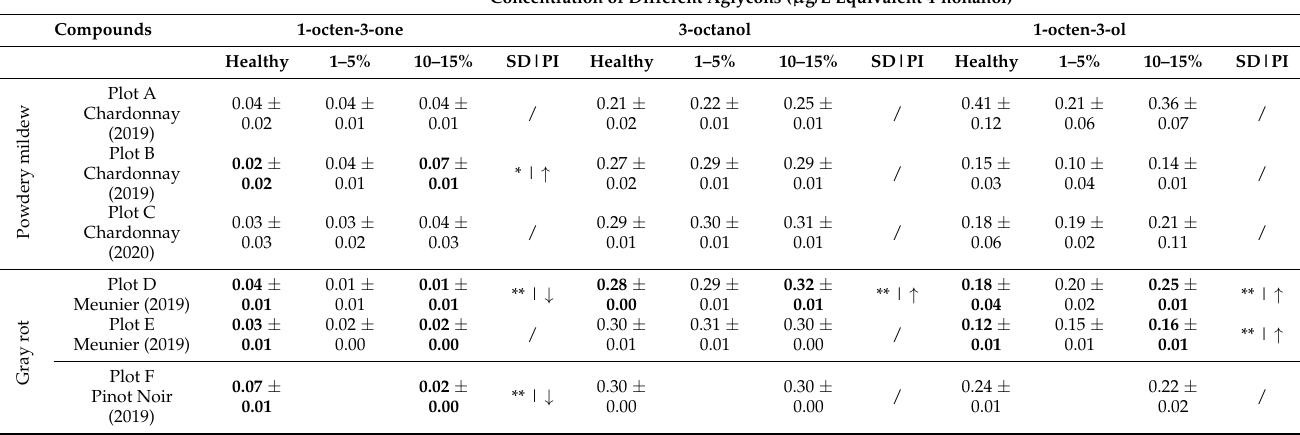
Table 3. Concentration in µ g equivalent of 4-nonanol of 1-octen-3-one, 3-octanol and 1-octen-3-ol aglycones in musts affected by powdery mildew and gray